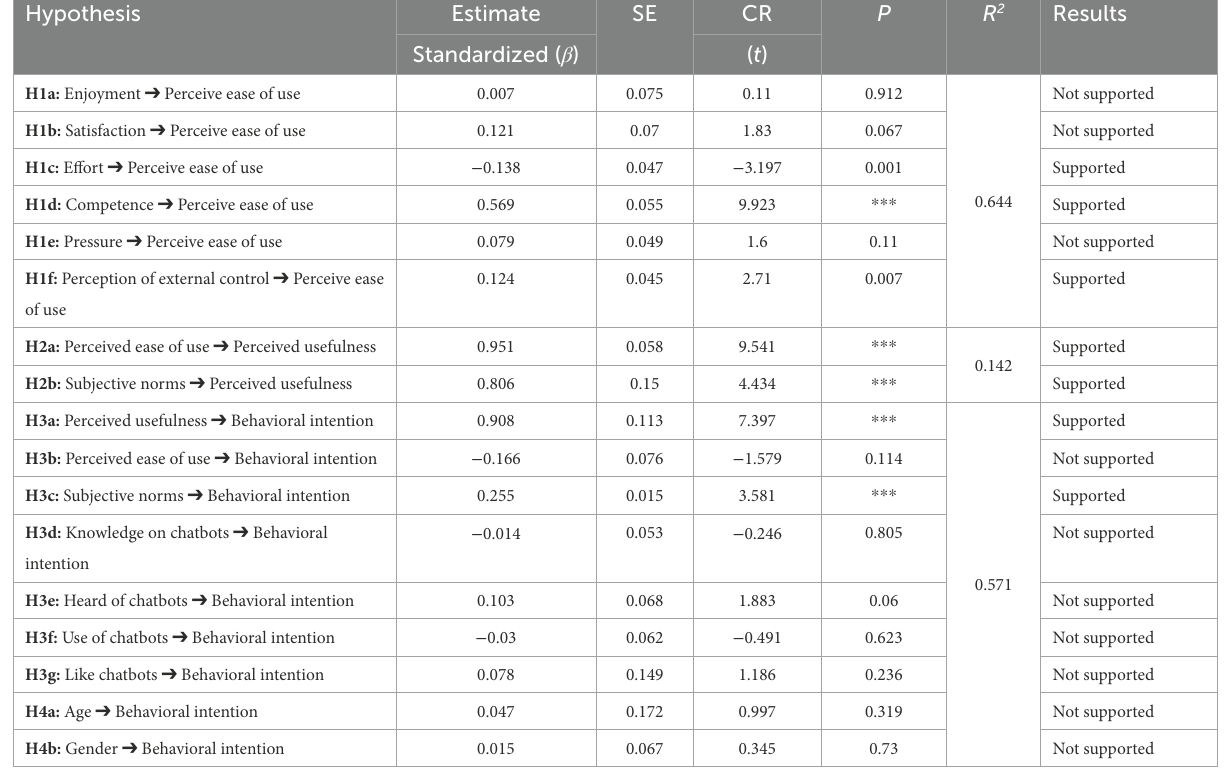
TABLE 7 The summary of the hypotheses